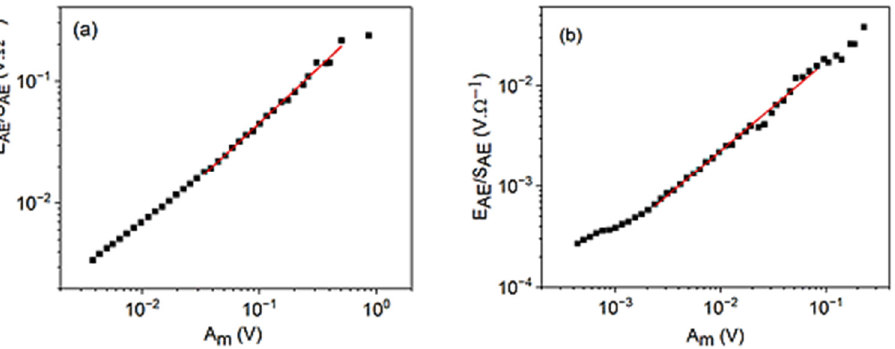
Figure 4. log E AE versus logA m plots for cooling in alloy A ( a ) at small, constant, external magnetic S AE Figure 4.    versus   plots for cooling in alloy A ( a ) at small, constant, external magnetic field (B = 250 mT) and for heating in alloy B ( b ) (at B =   field (B = 250 mT) and for heating in alloy B ( b ) (at B = 0).